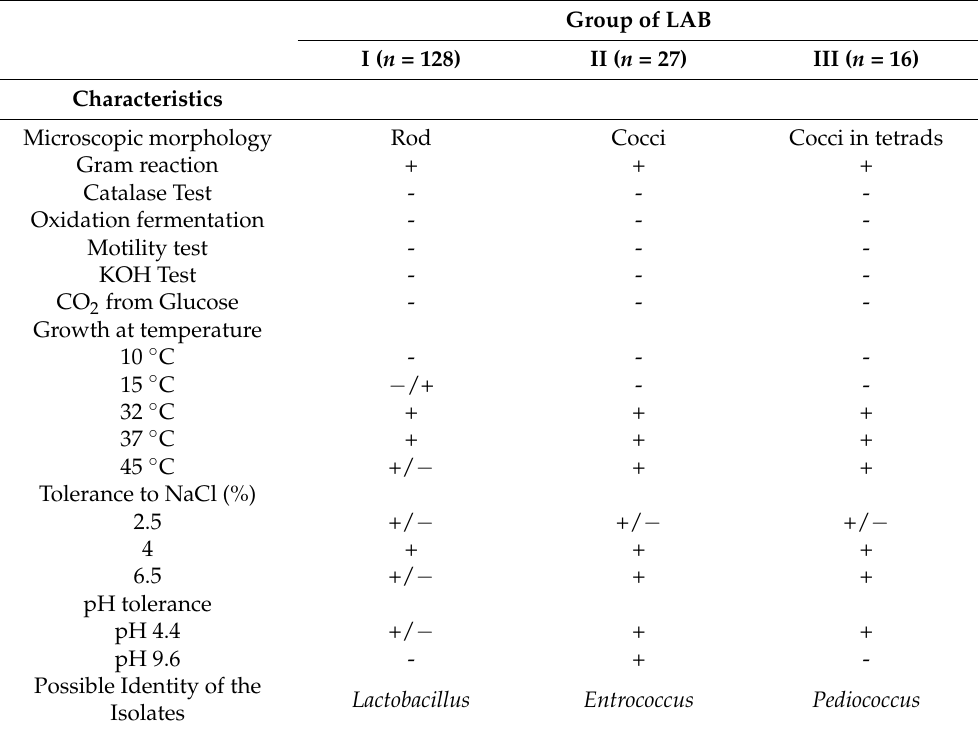
Table 4. Morphological, physiological and biochemical characteristics of LAB isolated from Shameta samples.